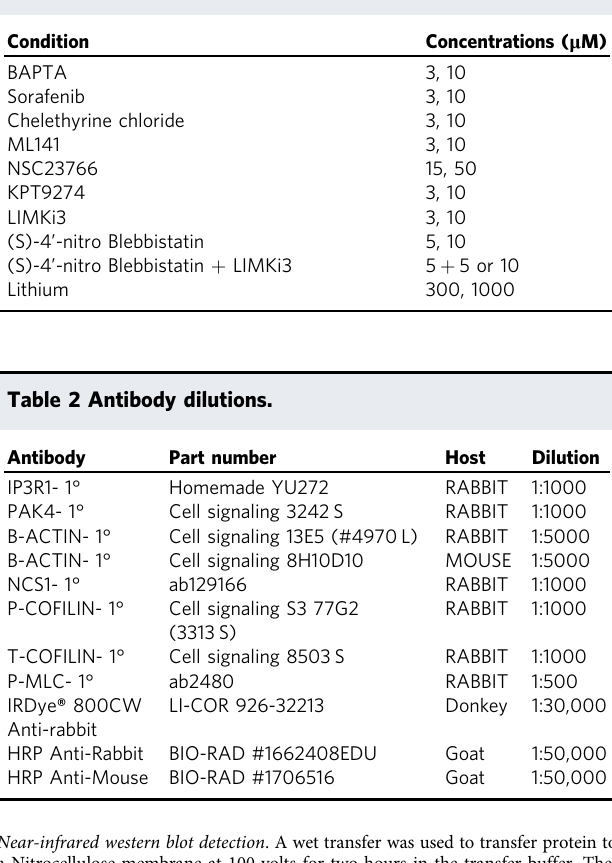
Table 1 Drug treatment dosages.